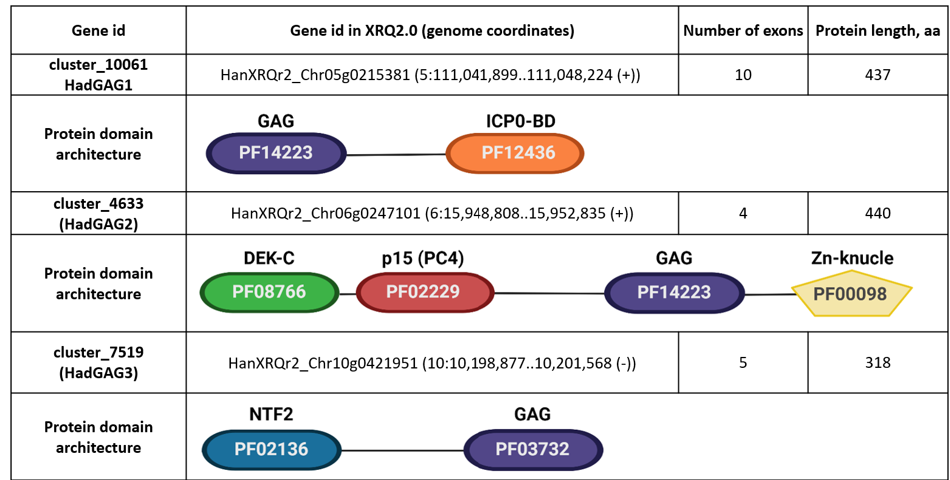
Figure 6. Genome location and domain architecture of nonLTR-RTEs encoding HadGAG